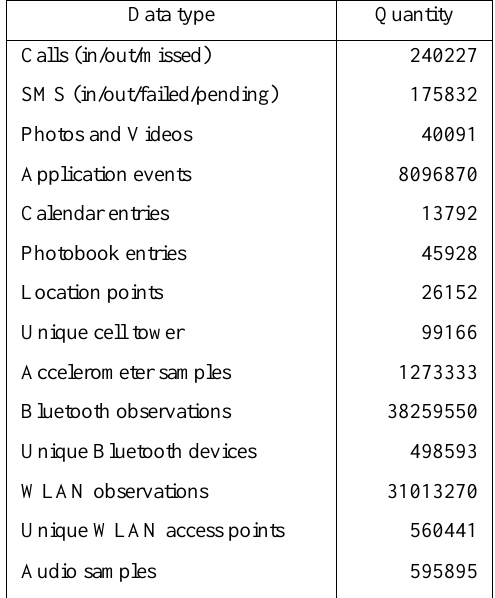
Table 1. Data types and their quantity